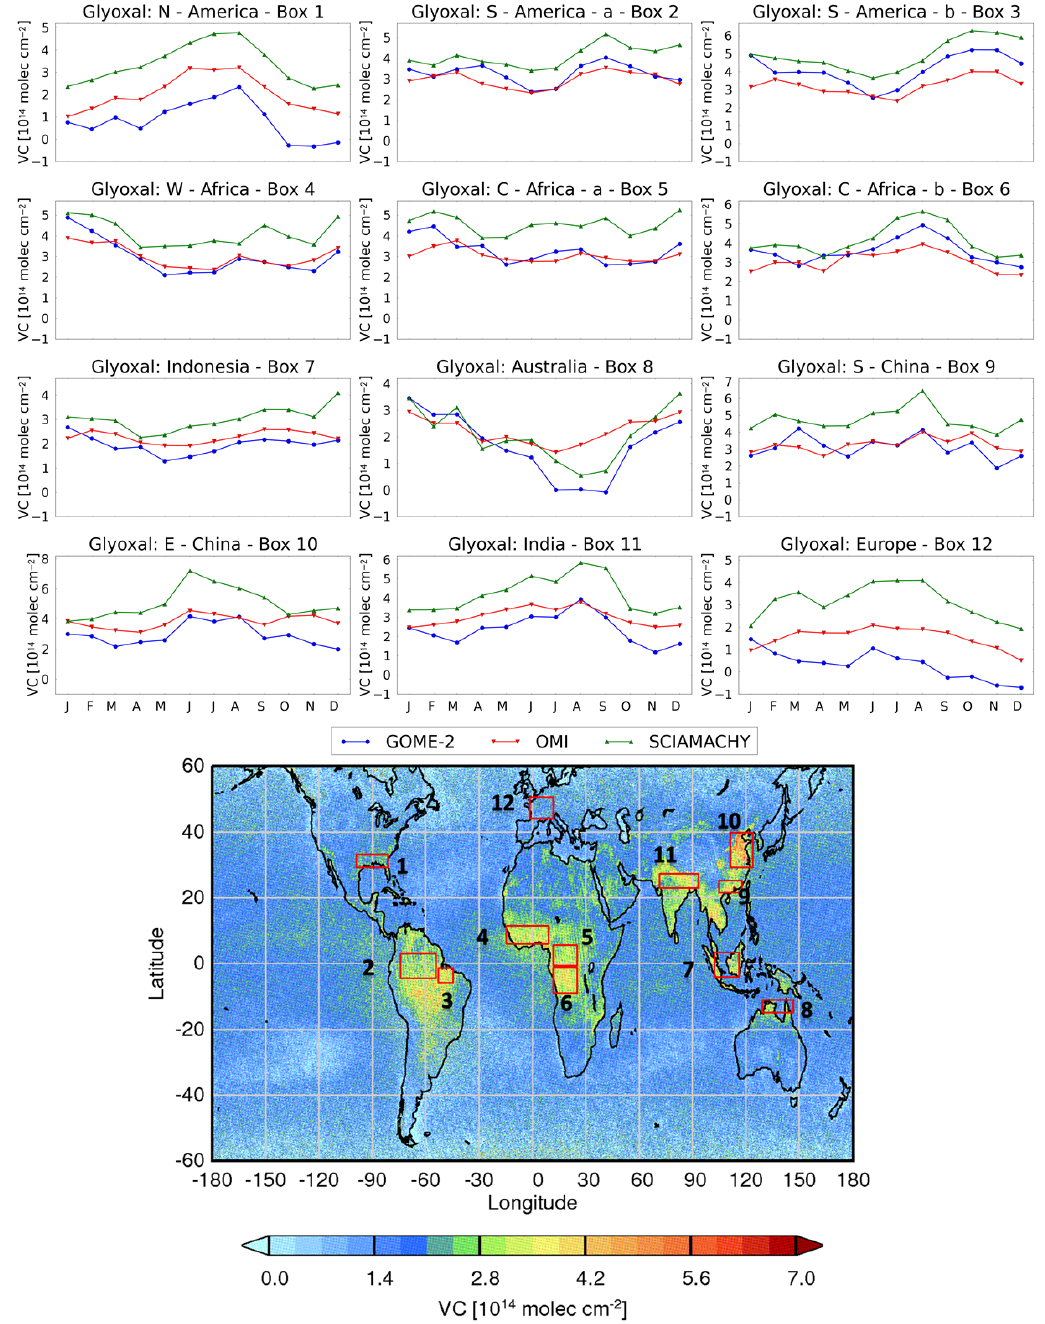
Figure 9. Comparison of monthly averaged CHOCHO VCs from OMI (red line), GOME-2 (blue line) and SCIAMACHY (green line) data for 12 selected regions (boxes 1–12) for 2007 (top). Annual global CHOCHO map with 12 selected regions for different environments